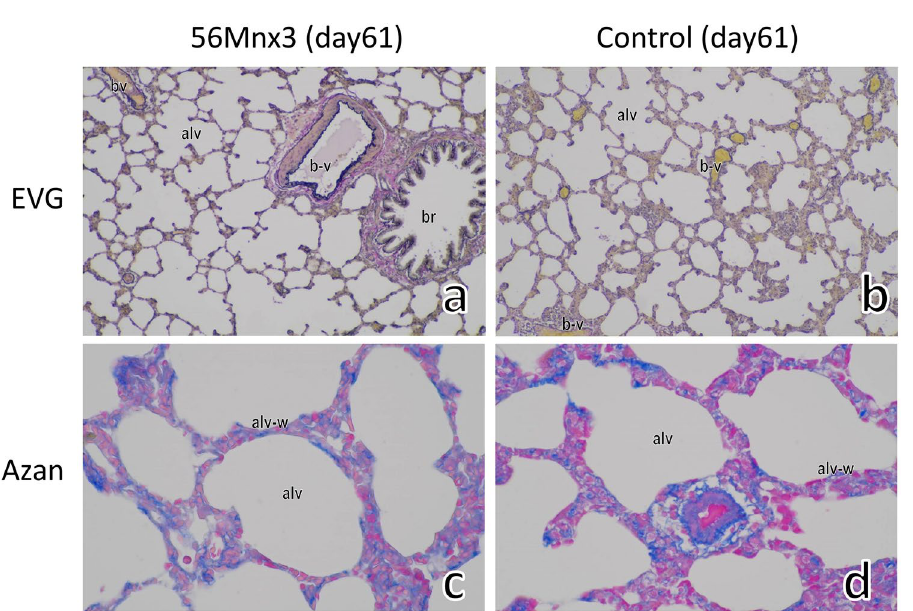
Figure 2. The lung of rats on day 61 after 56 MnO 2 exposure ( a , c ) and the control ( b , d ). EVG staining indicated no significant changes in elastin (dark blue or black color) in the alveoli (alv) by 56 Mn exposure ( a ). Azan staining showed no signs of increased collagen deposition (blue color) in the alveolus wall (alv-w) in the 56 Mnx3 group ( c ). Original magnification, × 100 ( a , b ), or × 400 ( c , d